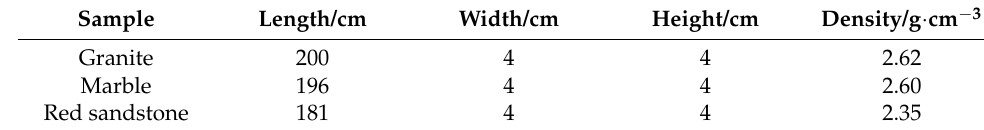
Table 1. Densities and dimensions of the rock samples.